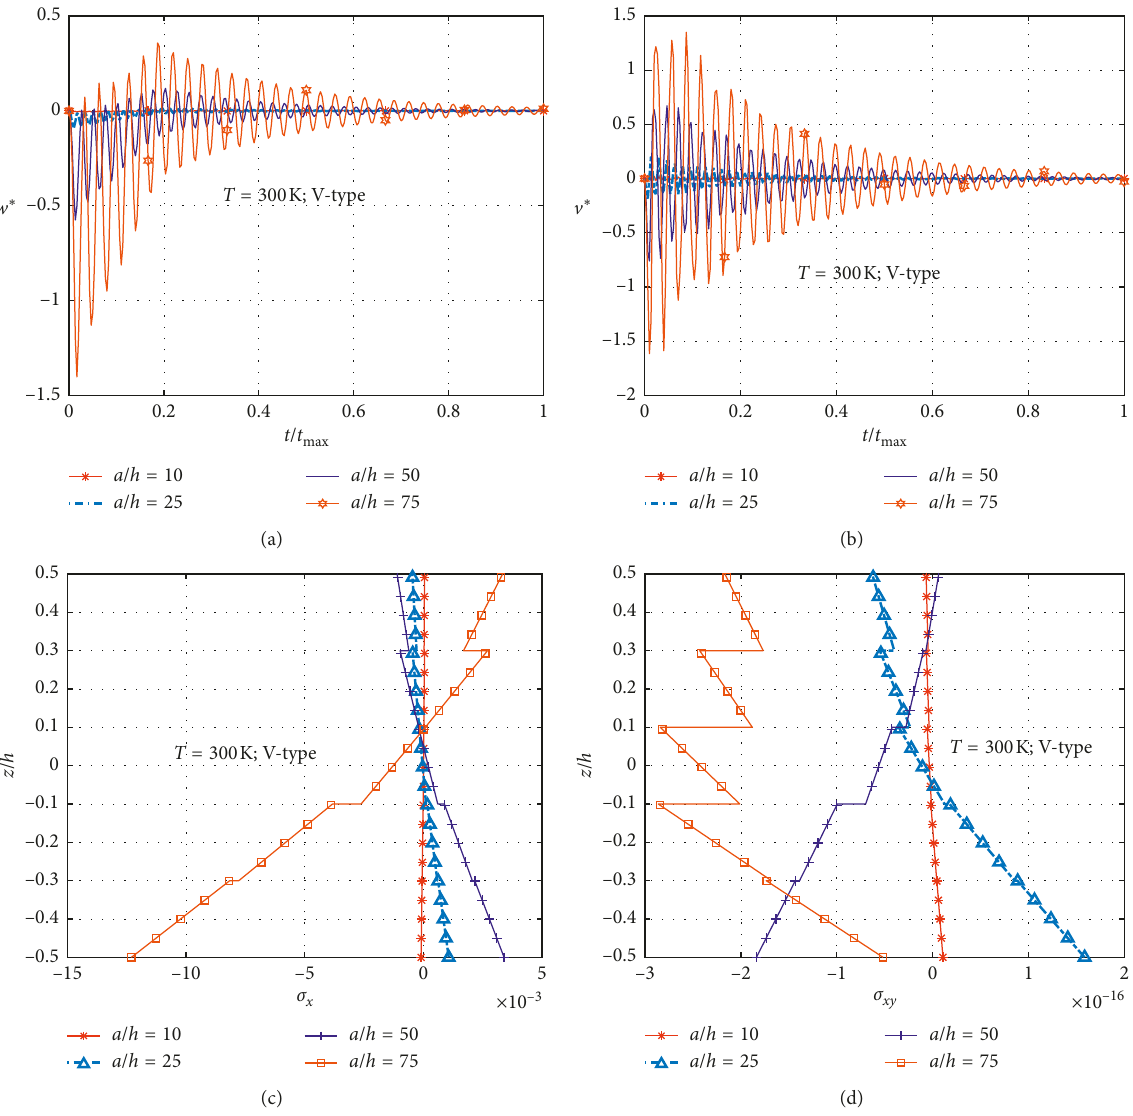
Figure 7: Influence of a/h ratio on nondimensional deflection, velocity, and stress of the center point at T ; (b) velocity v ; (c) stress σ x ; (d) stress σ xy (a) deflection w ∗ ∗